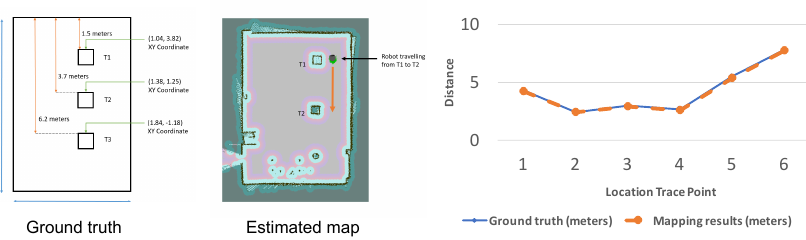
Figure 14. Comparison of the 2D mapping results and location trace estimation.